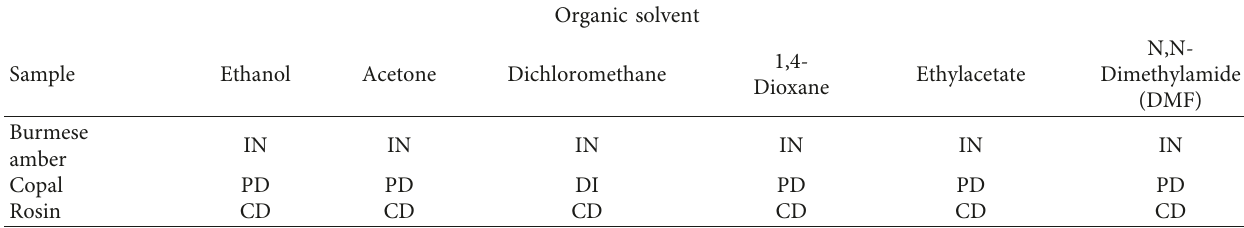
Table 3: Solubilities of amber, copal, and rosin samples in organic solvents. Organic